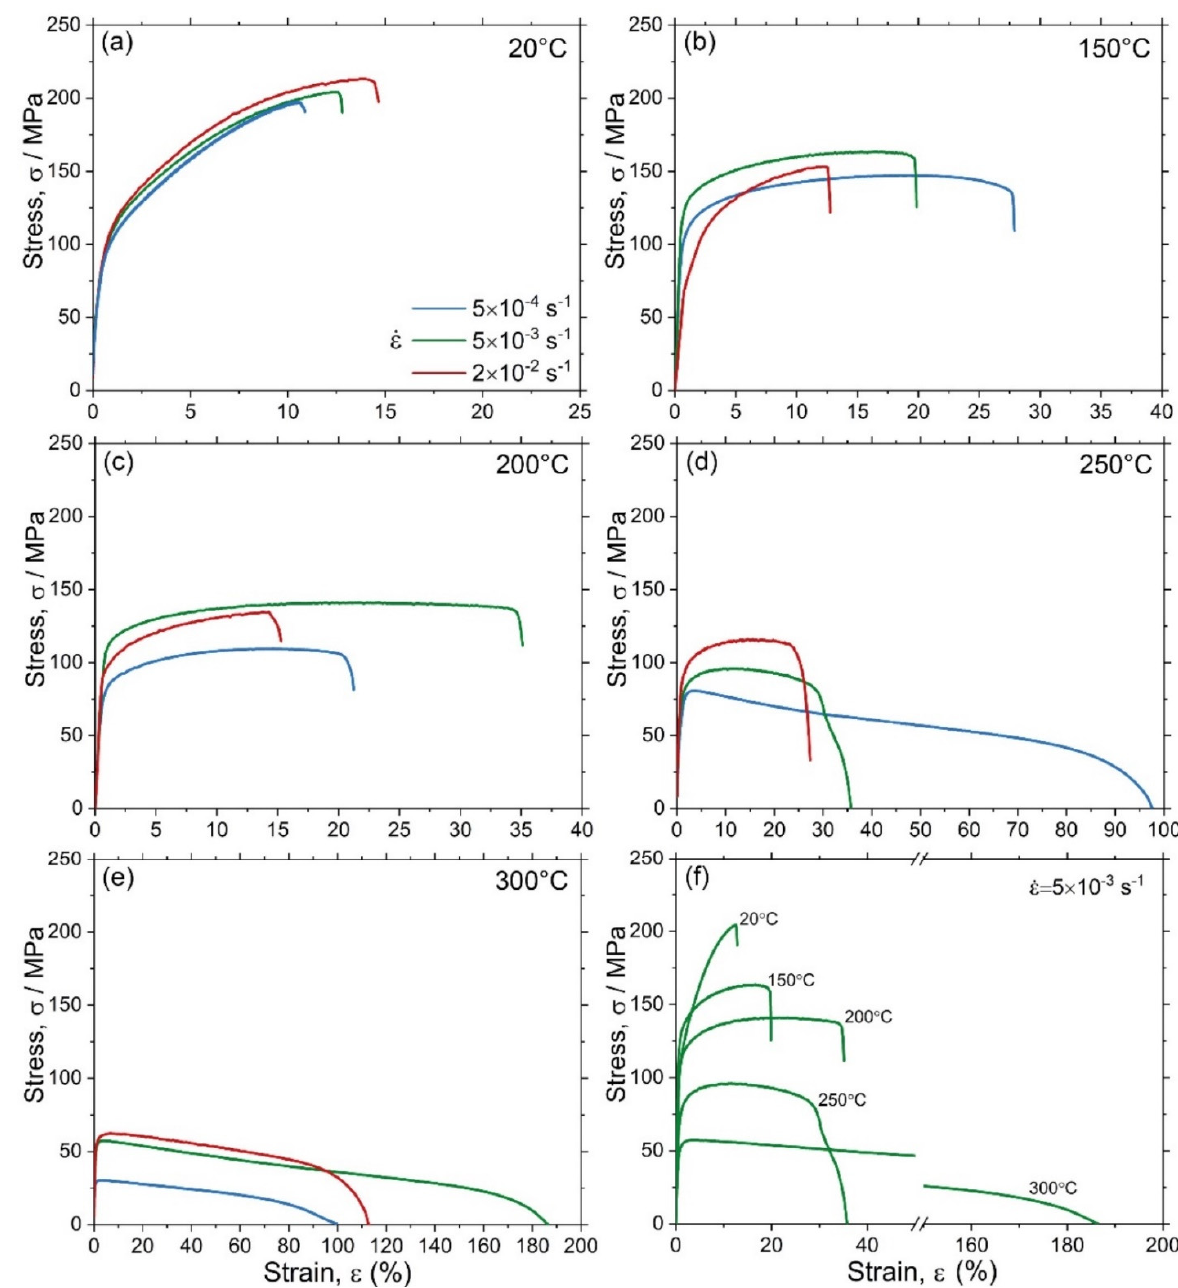
Figure 6. Tensile diagrams for the specimens tested at various temperatures and three strain rates (the colour coded legend shown in ( a ) applies to all plots): ( a ) 20 °C, ( b ) 150 °C, ( c ) 200 °C, ( d ) 250 °C, ( e ) 300 °C, and ( f ) the summary plot showing the evolution of the σ ( ε ) curves obtained at = 5 × 10 -3 s -1 with increasing test temperature.